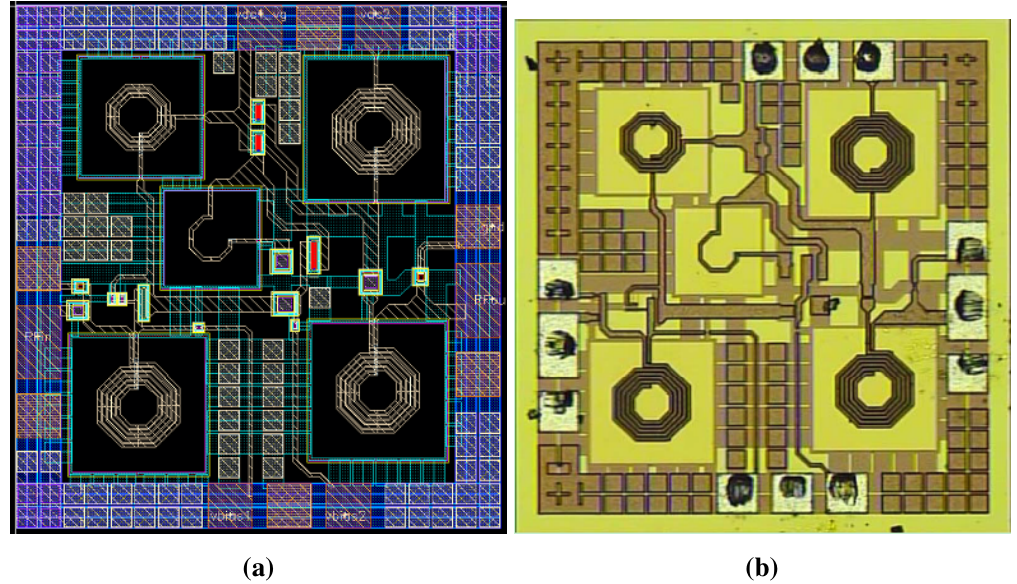
Figure 12. ( a ) Layout of the Class E power amplifier; ( b ) microchip view of the fabricated Class E power